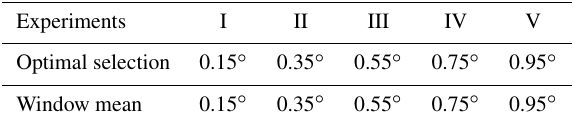
Table 1. Experiment design (window size) for two methods to de- velop